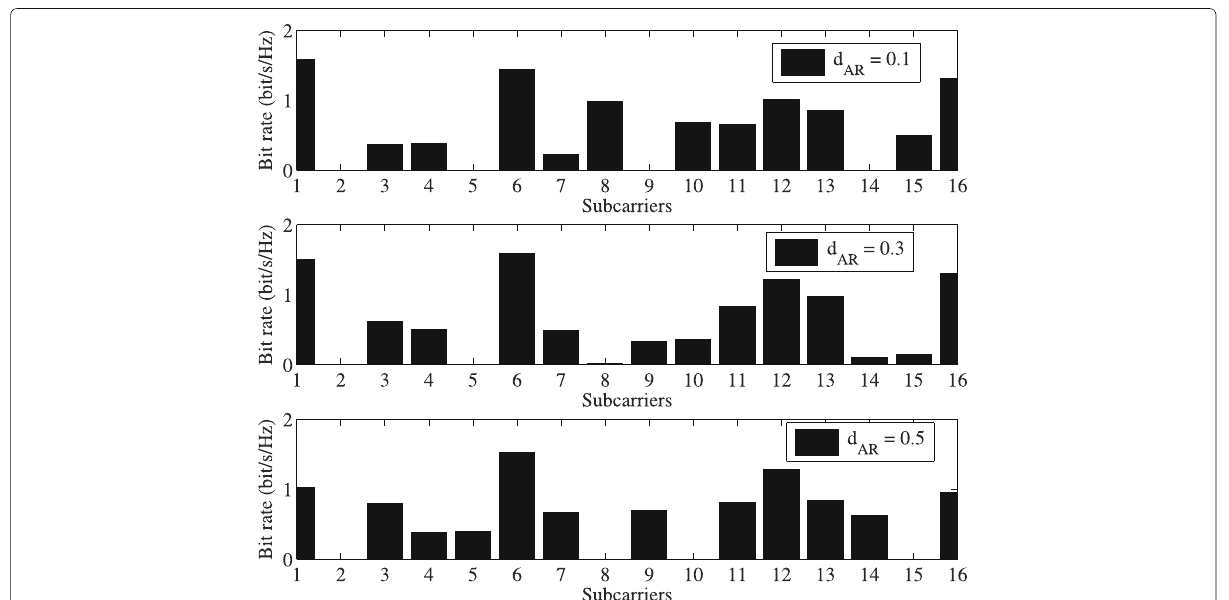
Fig. 2 The detailed information with respect to the assigned bit rates on each subcarrier, where three different channel cases are involved